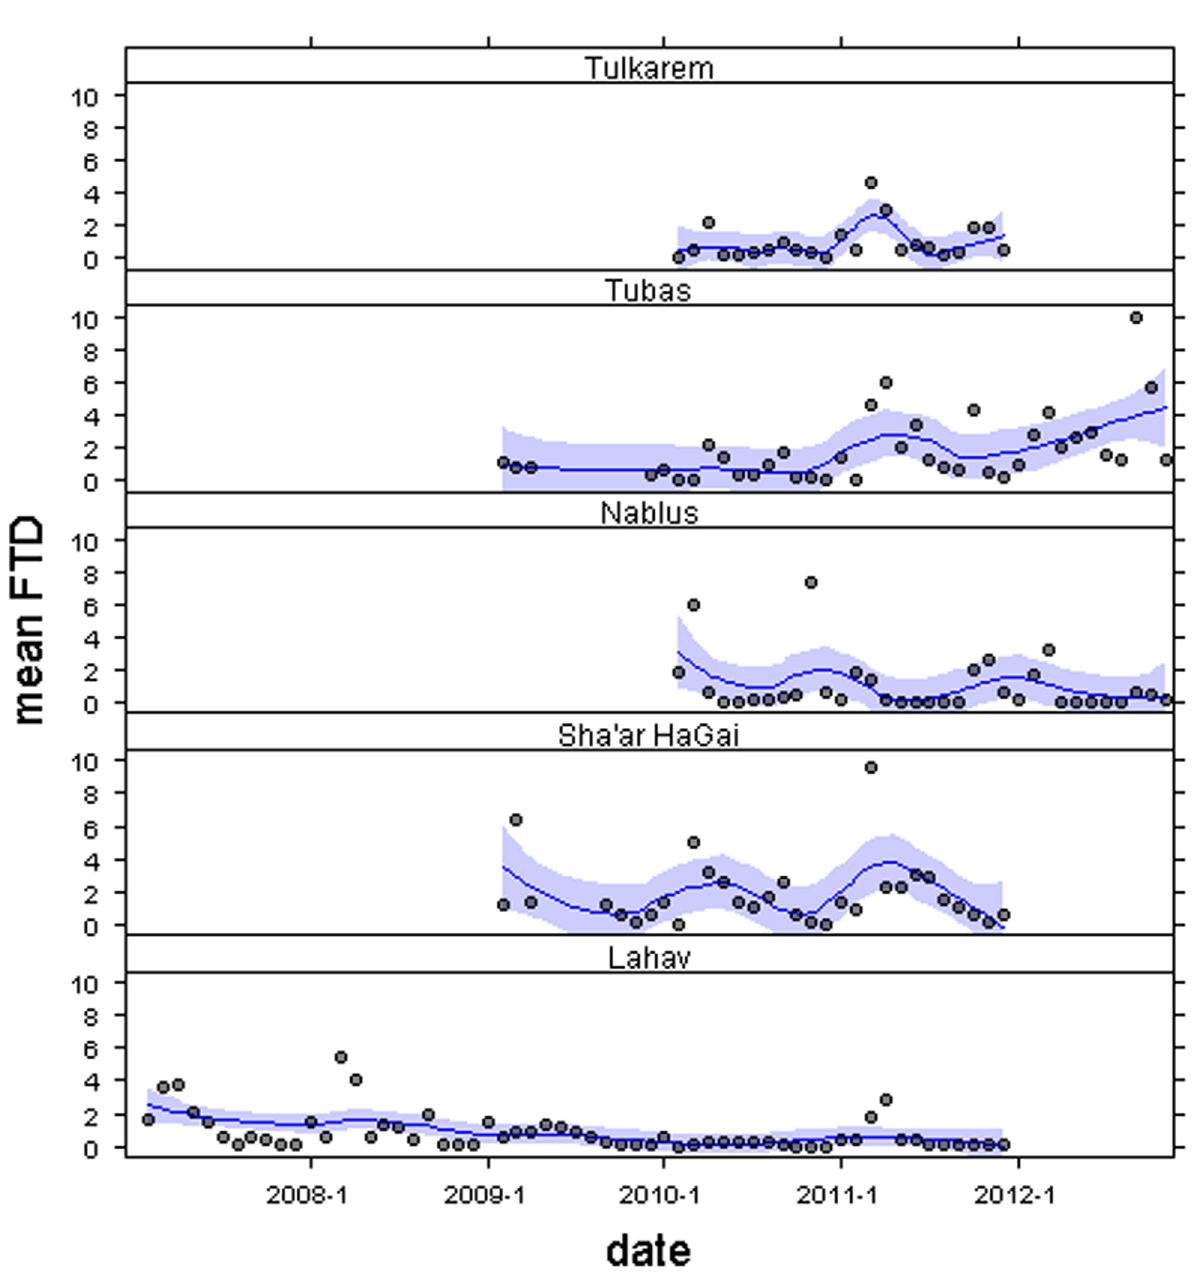
Fig 2. Time-series exploration. Profiles of monthly mean numbers of Bactrocera oleae flies/trap/day (FTD) between February 2007 and November 2012 for each site. The mean blue line has been adjusted with a loess function (weighted least square) with a 0.5 span and confidence bands with a 0.95 level of standard error. Ticks along the x-axis indicate January of the corresponding